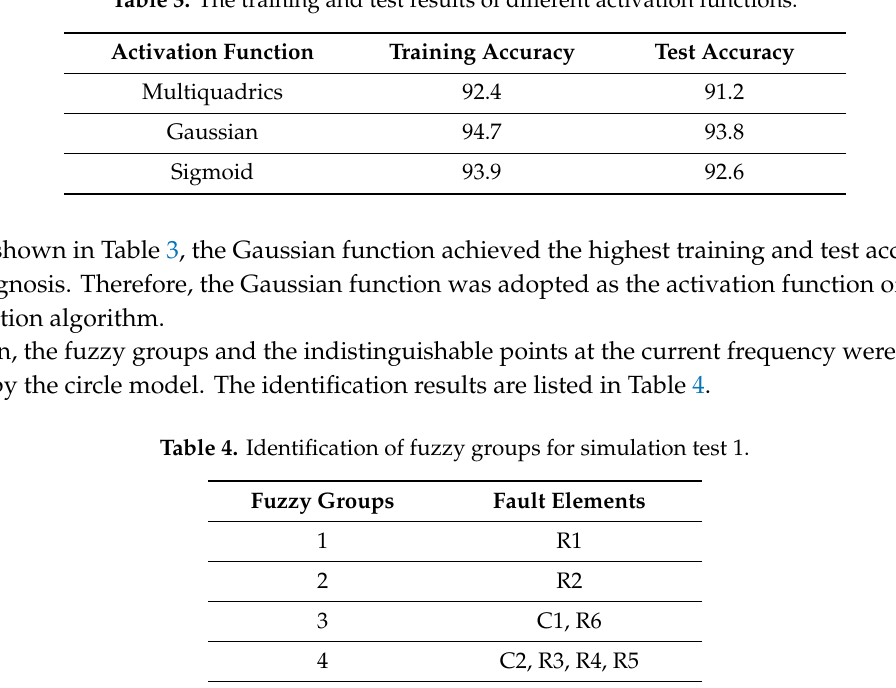
Table 3. The training and test results of di ff erent activation functions.